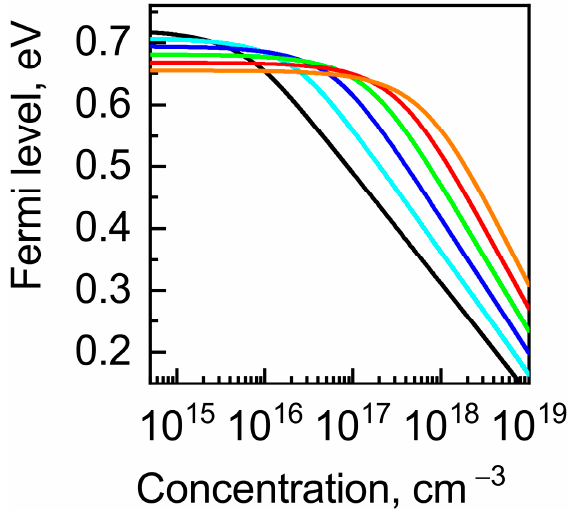
Figure 3. Fermi-level energy calculated as a function of charged vacancy concentration for different temperatures, K: 900 (black), 1000 (cyan), 1100 (blue), 1200 (green), 1300 (red), and 1400 (orange).